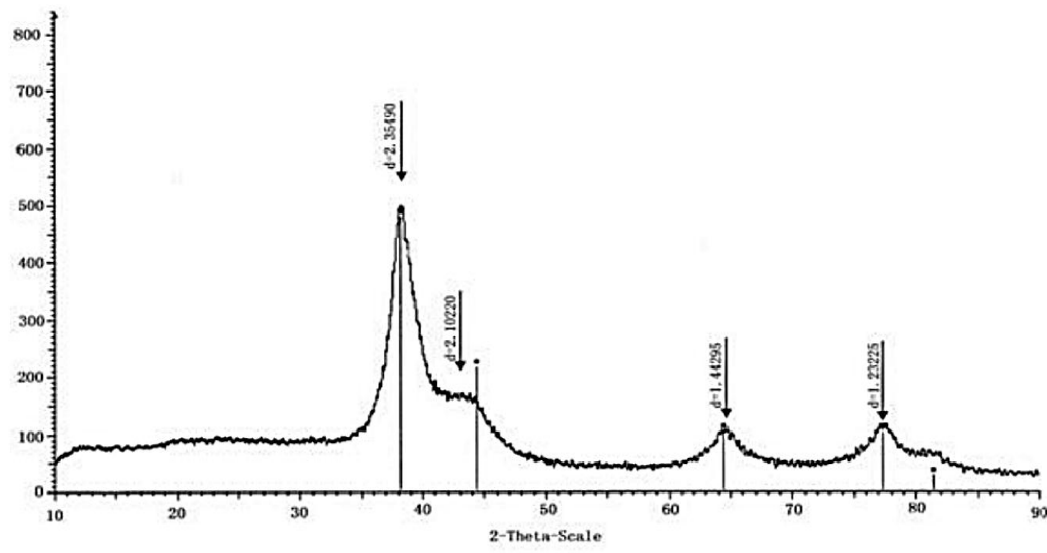
Figure.3. XRD pattern of Ag nanoparticles stabilized within peloid